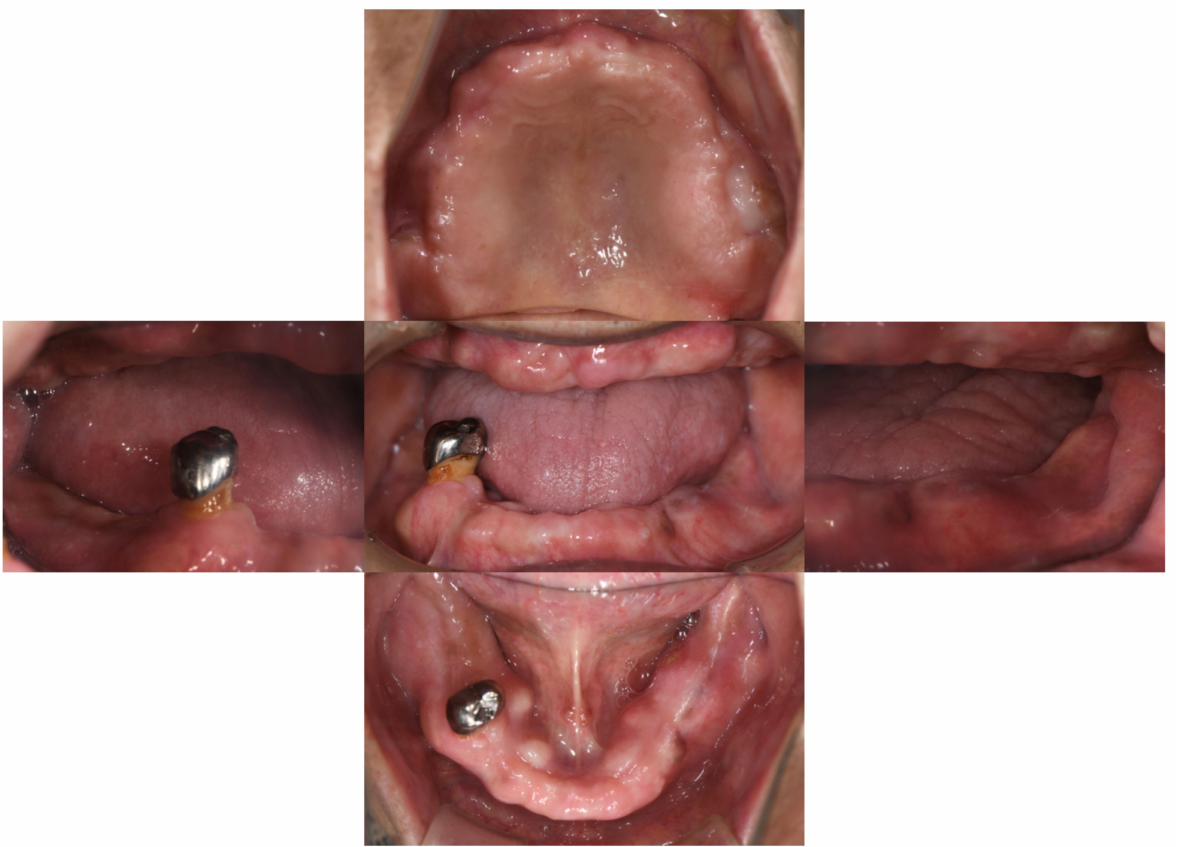
Figure 1. Intra-oral examination. The maxilla was completely edentulous. The mandible had only the lower right second premolar remaining.